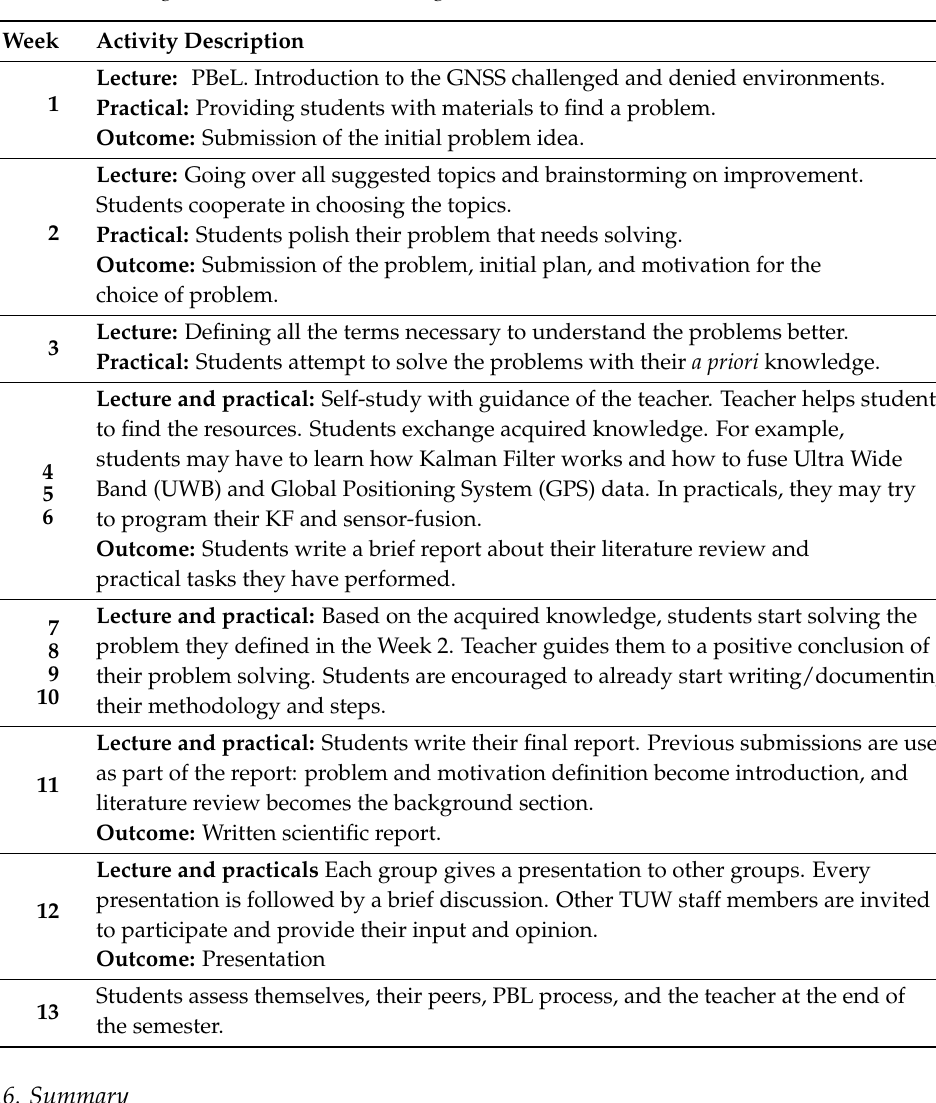
Table 8. Positioning in indoor and GNSS challenged environments course